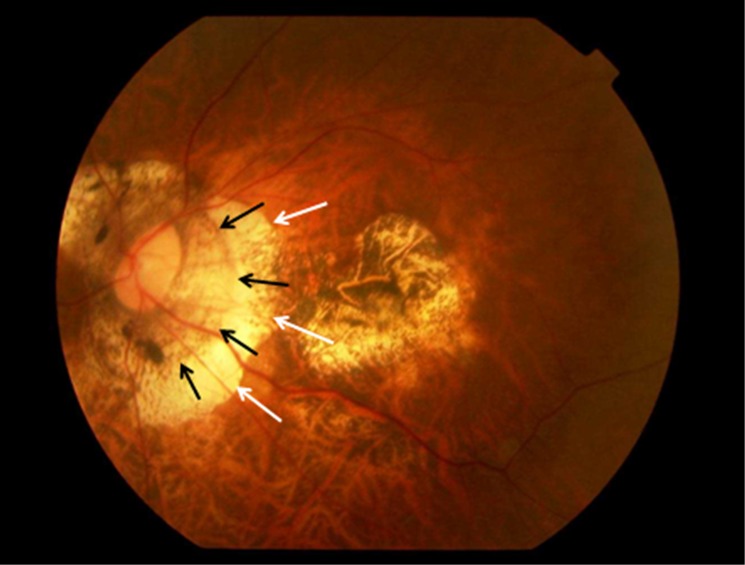
Fundus photograph of a highly myopic eye with parapapillary delta zone (black arrows) and gamma zone (white arrows).